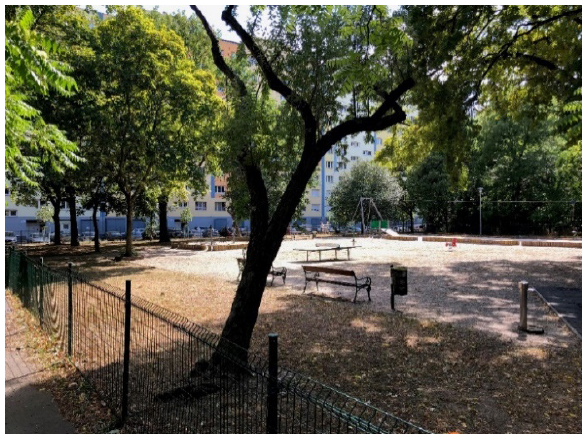
Figure 13. Kelenföld residential courtyard view, 2022